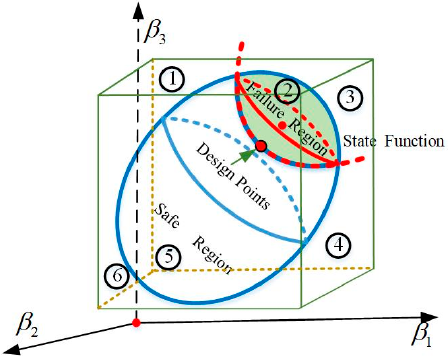
Figure 3. Hyperellipsoid set model.